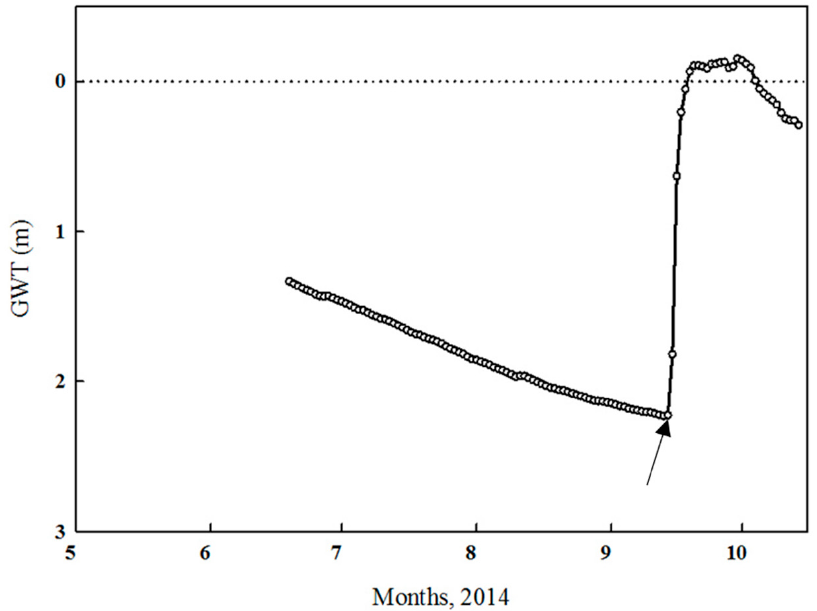
Figure 7. Groundwater table (GWT) for the Populus euphratica forest during the growing season in 2014. The arrow indicates the flood irrigation from the upper and middle reaches of the Heihe River detected at our study site after this day.